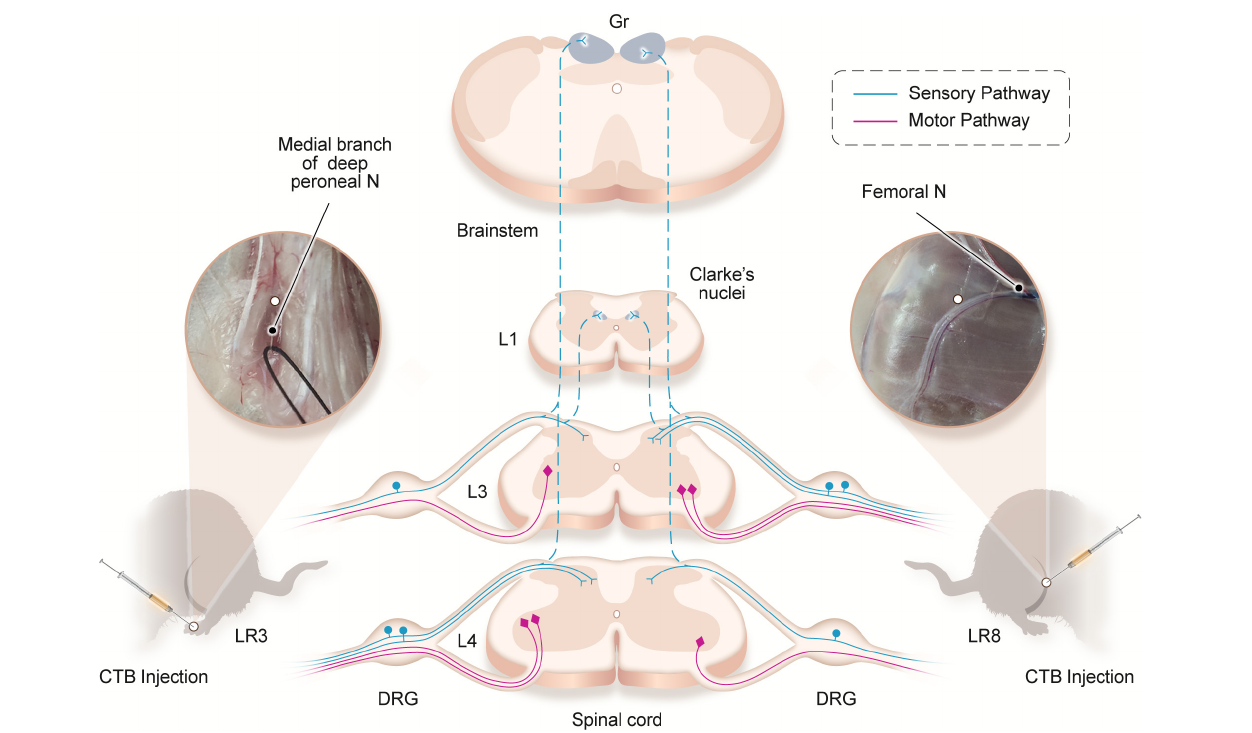
FIGURE 6 | Illustration of the distribution of the neural labeling associated with “Taichong” (LR3) and “Ququan” (LR8) through the sensory and motor pathways. Acupoints LR3 and LR8 establish their sensory and motor connections with the corresponding targets in the dorsal root ganglion (DRG), spinal dorsal horns, Clarke’s nucleus, gracile nucleus (Gr), and spinal ventral horns in the segmental and regional